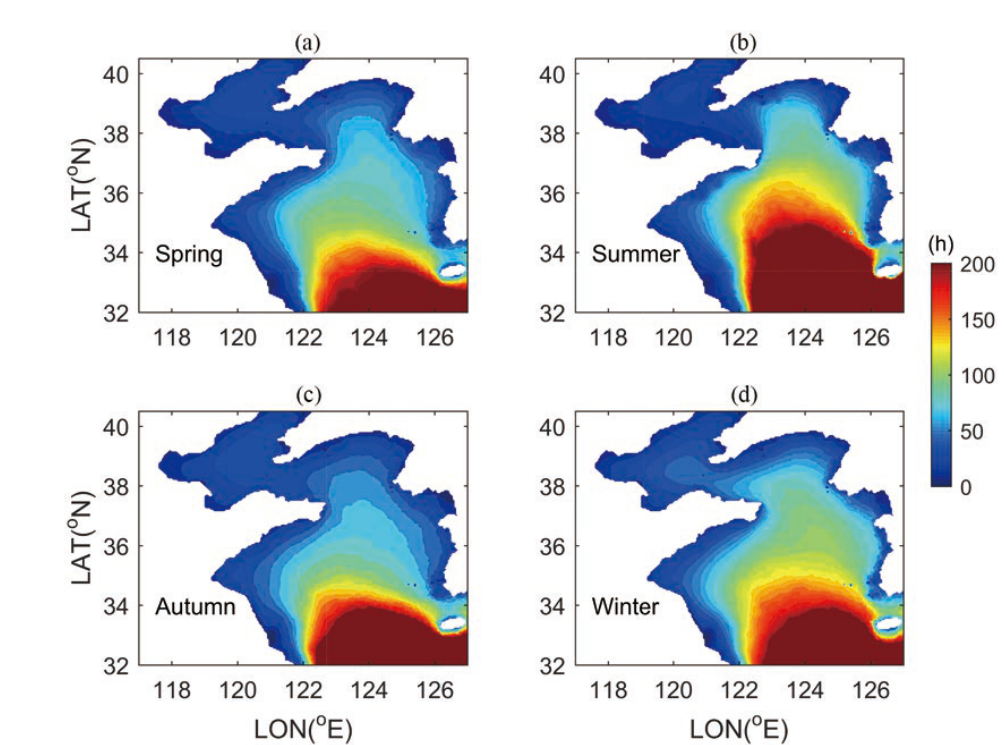
Figure 11. Seasonal average wave energy event duration (( a ) Spring; ( b ) Summer; ( c ) Autumn; ( d ) Winter).